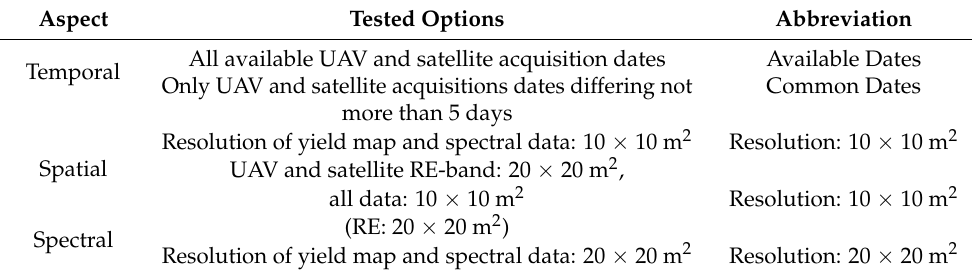
Table 2. Tested concepts to modify the UAV and satellite data base. Each of the options of one aspect can be combined with every option of the other aspects, resulting in 8 different satellite and 12 UAV scenarios. All acquisition dates and the selected dates for the “Common Dates”-option are listed in Table A3. Aspect Tested Options Abbreviation